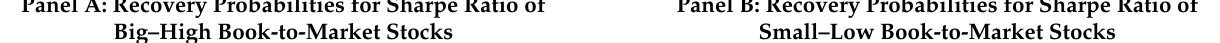
Table 1. Recovery Probabilities for Sharpe ratio of Six Types of Stocks for Different Time Periods. Panel A: Recovery Probabilities for Sharpe Ratio of Panel B: Recovery Probabilities for Sharpe Ratio of Big–High Book-to-Market Stocks Small–Low Book-to-Market Stocks